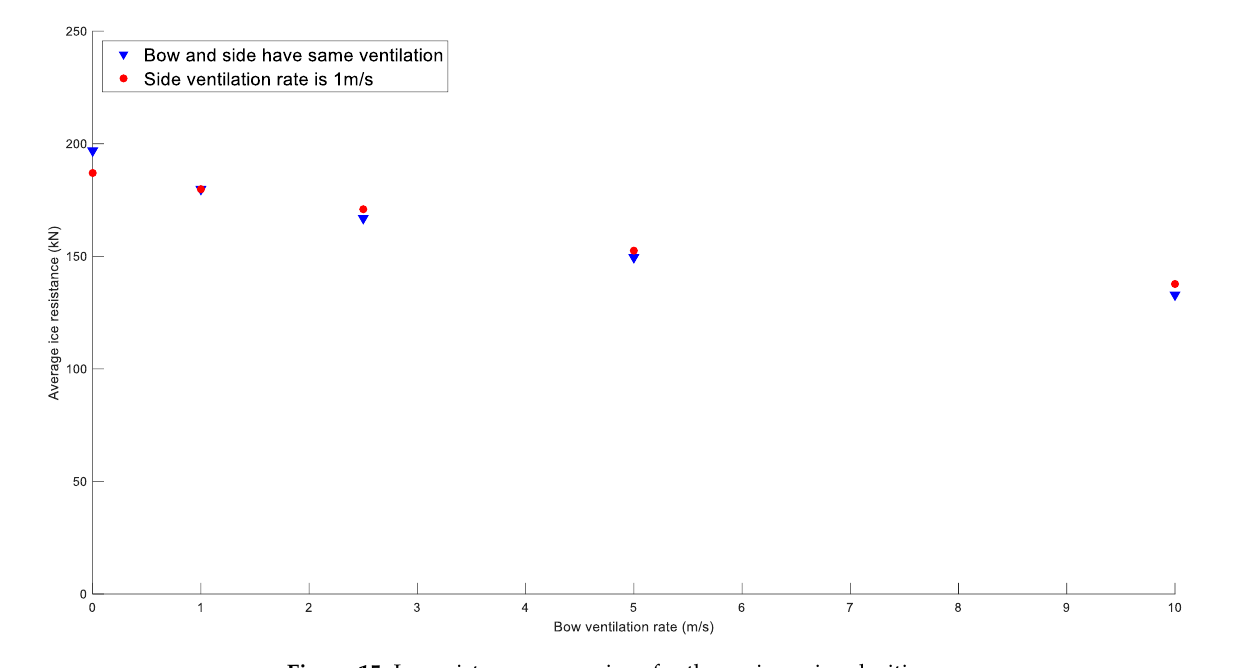
Figure 15. Ice resistance comparison for the various air velocities.